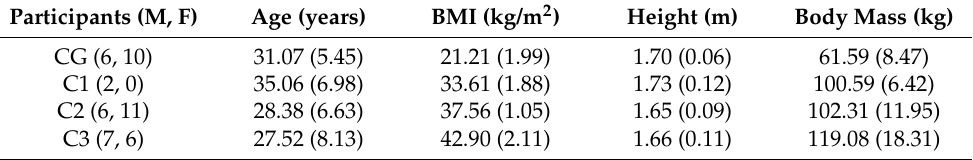
Table 1. Anthropometric and clinical features of participants. Values are expressed as mean (SD). Participants (M,